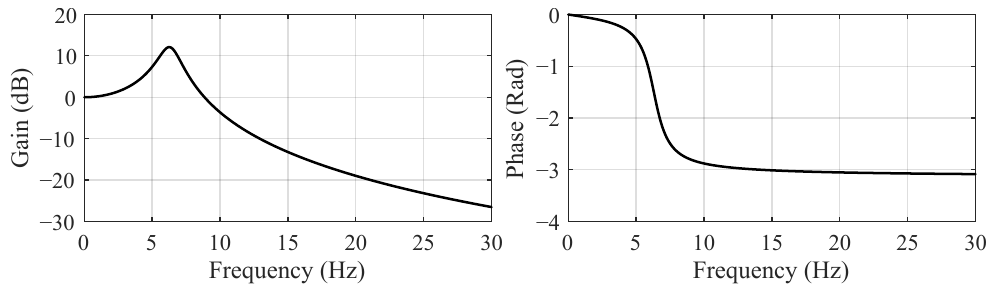
Figure 12. Frequency response of the low-pass filter: z 1 = 1600s − 2 , z 2 = 10s − 1